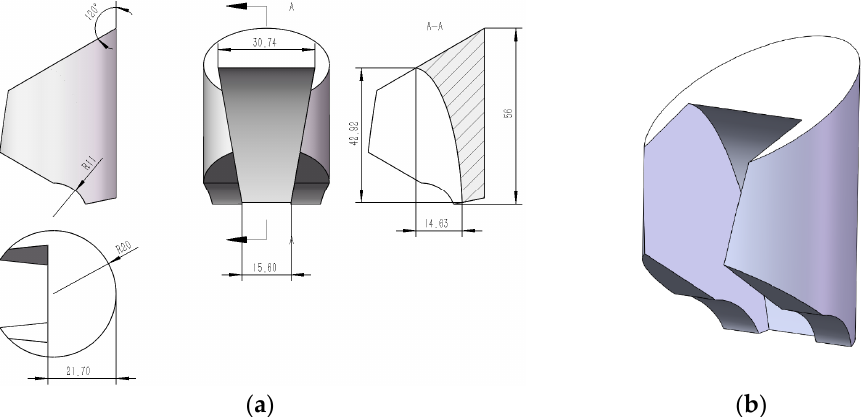
Figure 19. Shape and size of the inverted hook for guiding seeds. ( a ) Two-dimensional view. ( b ) Three-dimensional view.